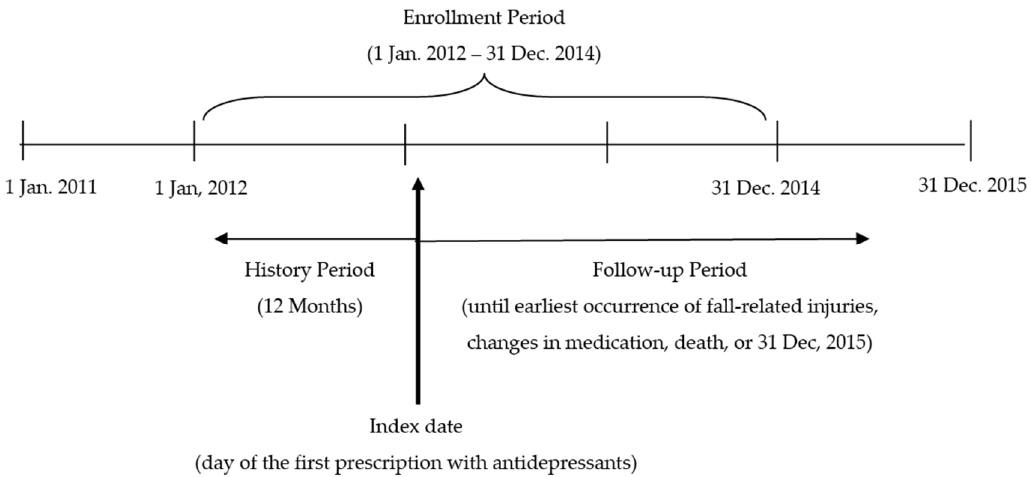
Figure 1. The study design for eligible patient selection.